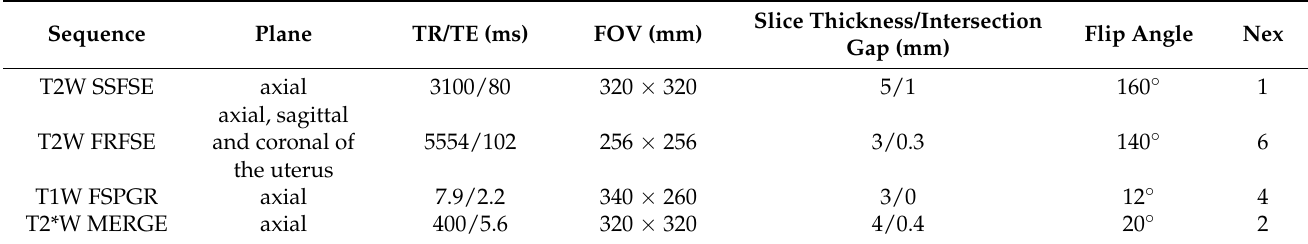
Table 1. MRI protocol used in the